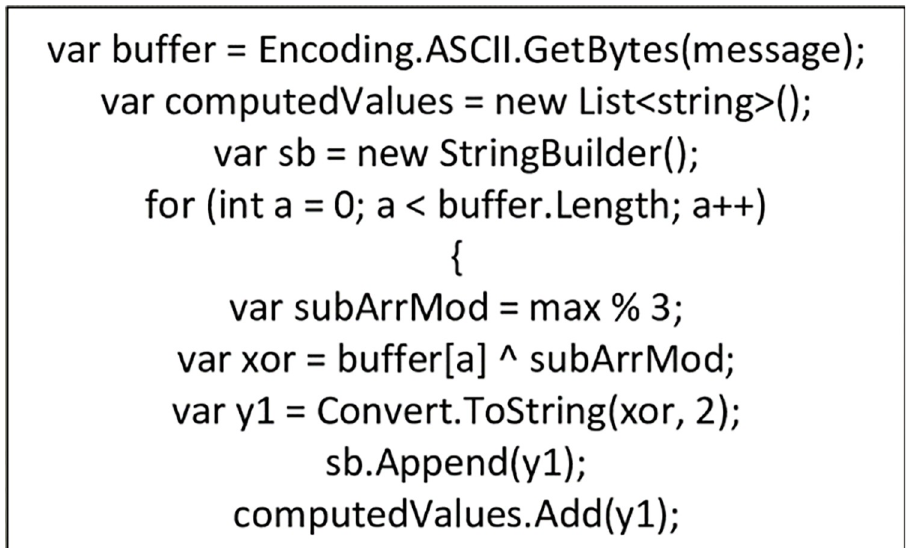
Fig 9. Encryption of plaintext into eight-bit string in